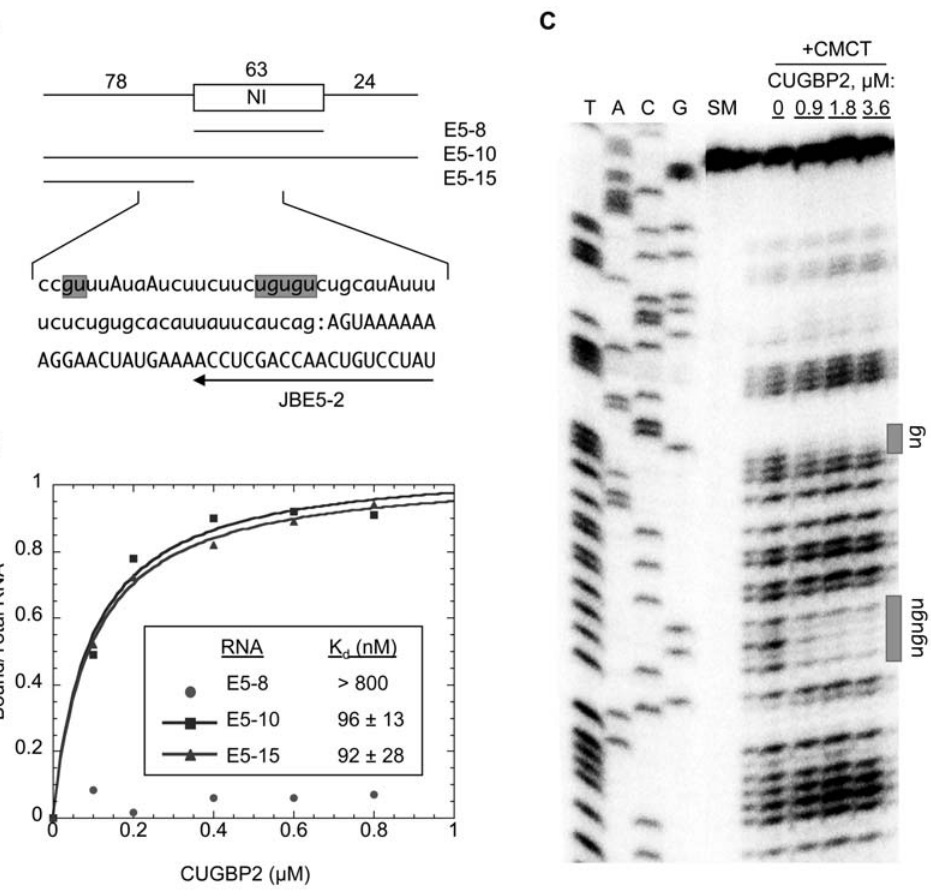
Figure 1. CUGBP2 contacts multiple motifs in the intron upstream from the NI cassette exon. (A) Schematic of the NI exon (rectangle) and flanking introns (lines) are shown with corresponding nucleotide lengths (numbers, top). RNA substrates (E5-8, E5-10, and E5-15) used for filter binding assays are indicated below. Sequence analyzed by footprinting using primer JBE5-2 (arrow) includes the intron (lower case) and exon (uppercase) region of the 3 9 splice site (colon). Shaded sequences represent regions protected from chemical modification by CUGBP2. Individual adenosines in uppercase represent branchpoints determined by primer extension (see below, Figure 4). (B) Nitrocellulose filter binding analysis. 32 P- labeled RNA substrates from (A) were assembled with purified recombinant CUGBP2 protein and separated into protein bound and unbound fractions. Representative graphs for each RNA substrate are shown. Inset: K d values were calculated as the average of three experiments; 6 , standard deviation. (C) RNA footprint analysis. E5-10 RNA was chemically modified with CMCT in the presence or absence of purified CUGBP2 protein. Modified positions were detected by primer extension (lanes + CMCT), in reference to a sequencing ladder generated from plasmid, E5-10 (lanes T,A,C,G). Shaded rectangles at right represent protected regions highlighted in the sequence shown in (A). Primer extension of starting material without modification is shown (lane SM).